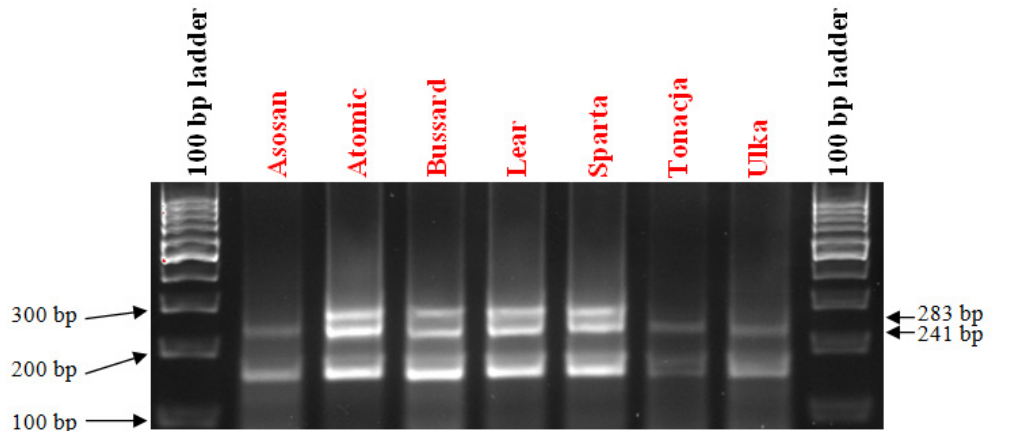
Figure 4: Electrophorogram showing the presence of the following markers: Xcfd81 of the Pm2 gene and STS_241 of the Pm4b gene in wheat varieties.